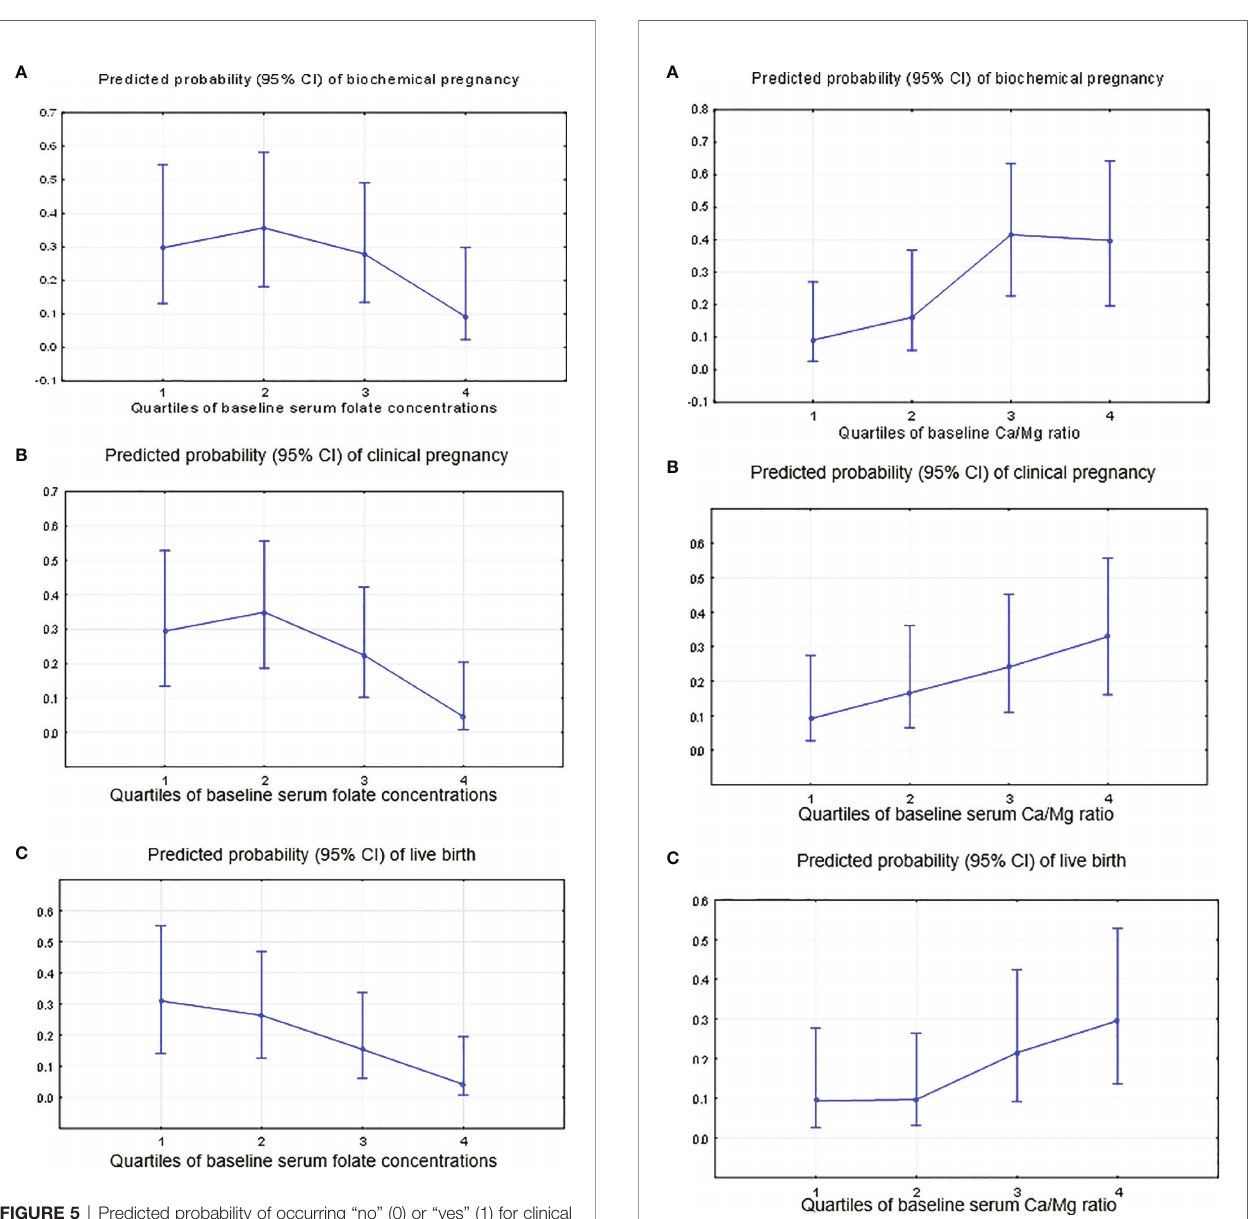
FIGURE 6 | Predicted probability of occurring “ no ” (0) or “ yes ” (1) for clinical ART outcomes by the quartiles of the serum Ca/Mg ratio. (A) Biochemical pregnancy, adjustment for continuous red blood cells, baseline serum FSH and antithrombin. (B) Clinical pregnancy, adjustment for continuous red blood cells and baseline serum FSH. (C) Live birth, adjustment for continuous red blood cells and baseline serum